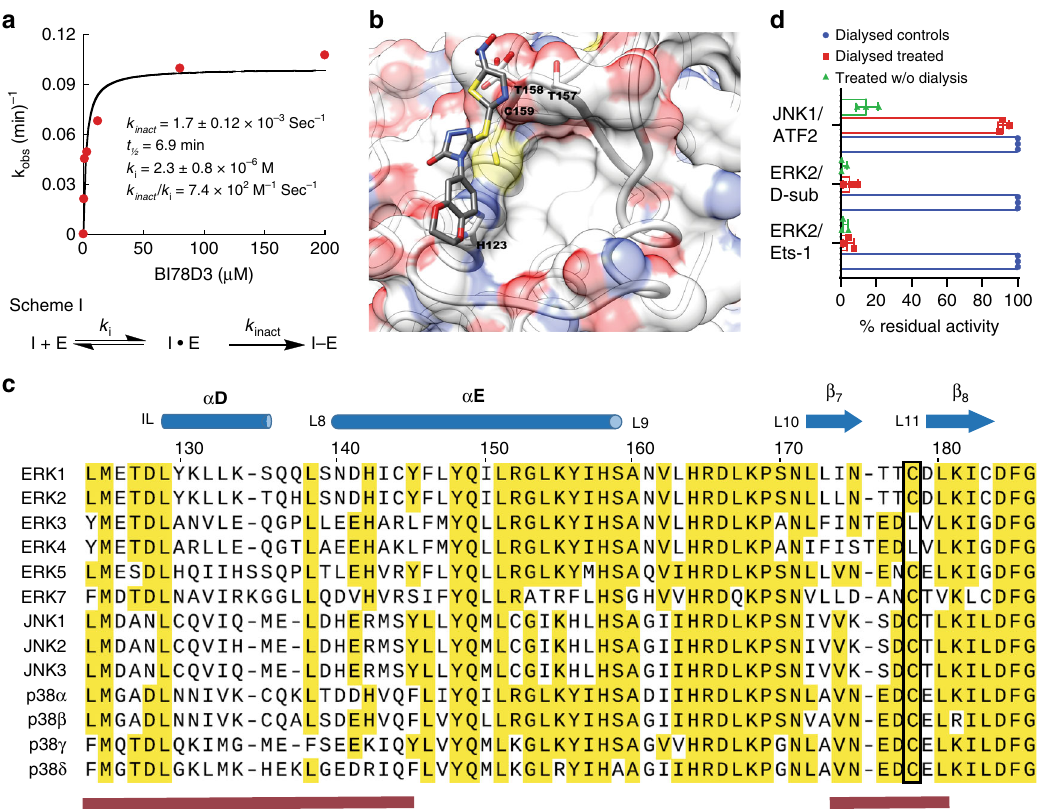
Fig. 3 BI-78D3 exhibits a unique selectivity towards ERK1/2. a Kinetic behavior of ERK2 inactivation by BI-78D3. Data were fi t to Eq. (1) as described in the methods section and according to the two-step mechanism of activation shown in Scheme 1 (data represents one experiment out of two repetitions; both produced consistent kinetic parameters, values of K i and k inact ± standard error). b The fi nal frame of a 100 ns molecular dynamics trajectory for BI-78D3 binding to ERK2 (PDB 4ERK). The fi gure was generated using UCSF Chimera software (https://www.cgl.ucsf.edu/chimera/) 70 . c Sequence alignment of Human MAPKs encompassing the D-recruitment site. The cysteines corresponding to C159 in ERK2 (targeted by BI-78D3) are indicated by the black rectangle; the numbering corresponds to human ERK1 sequence. C178 in Homo sapiens ERK1 corresponds to C161 in Homo sapiens ERK2 and C159 in